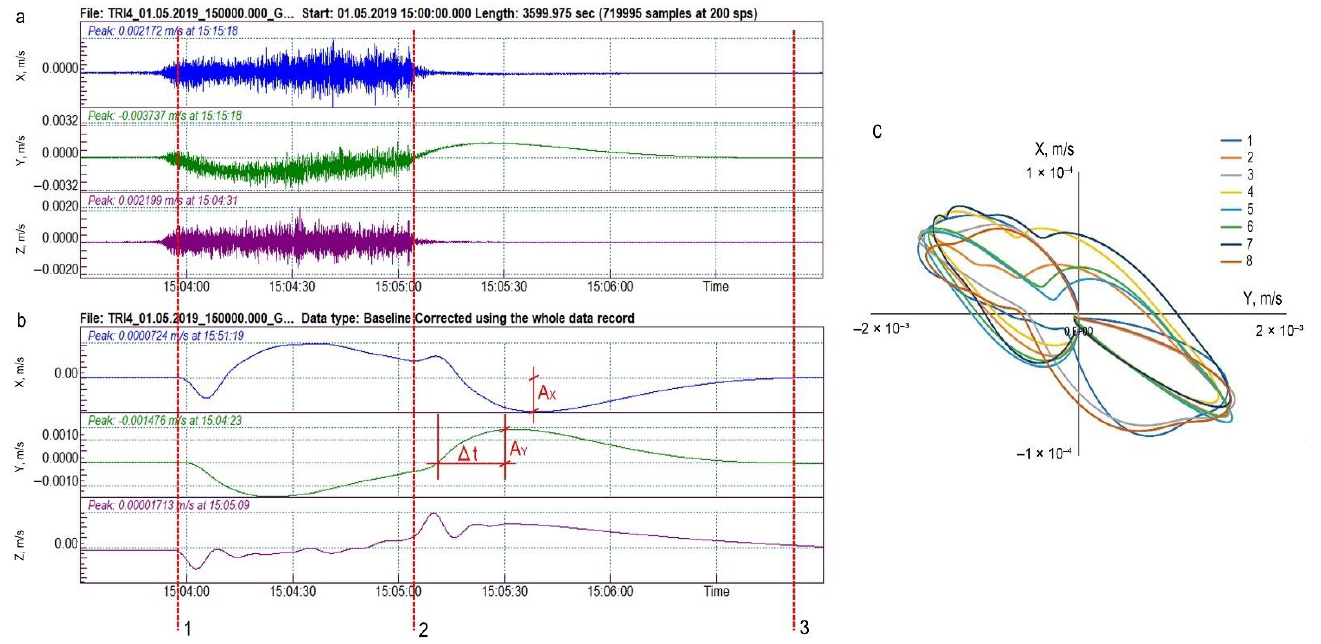
Figure 1. Typical seismic waveforms produced by a cargo train: ( a ) original waveforms; ( b ) wave- forms after lowpass filter 0.1 Hz. 1–2—passing train, 2–3—subgrade relaxation. Vertical lines are timestamps for (1) train head and (2) train tail passage. The period ∆ t is a lateral relaxation time of the subgrade-ground system. After train passage: A X —minimum amplitude in the longitudinal railway direction; A Y —maximum amplitude in the transverse railway direction. ( c ) Diagrams of the subgrade movement at the seismometer installation site in the horizontal plane during the cargo train passages (lines 1–8).